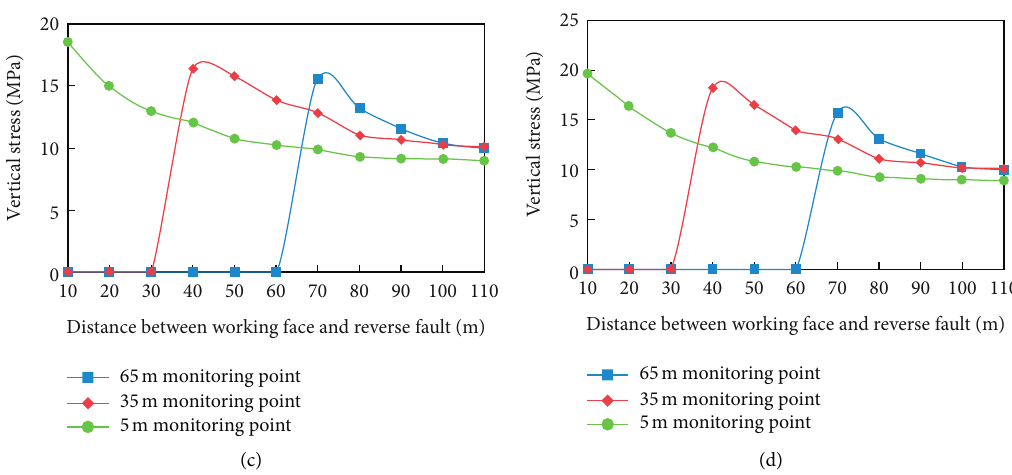
Figure 15: Variation curve of the vertical stresses at the monitoring points with different fault throw. (a) The throw of reverse fault is 4m. (b) The throw of reverse fault is 10m. (c) The throw of reverse fault is 15m. (d) The throw of reverse fault is 20m.